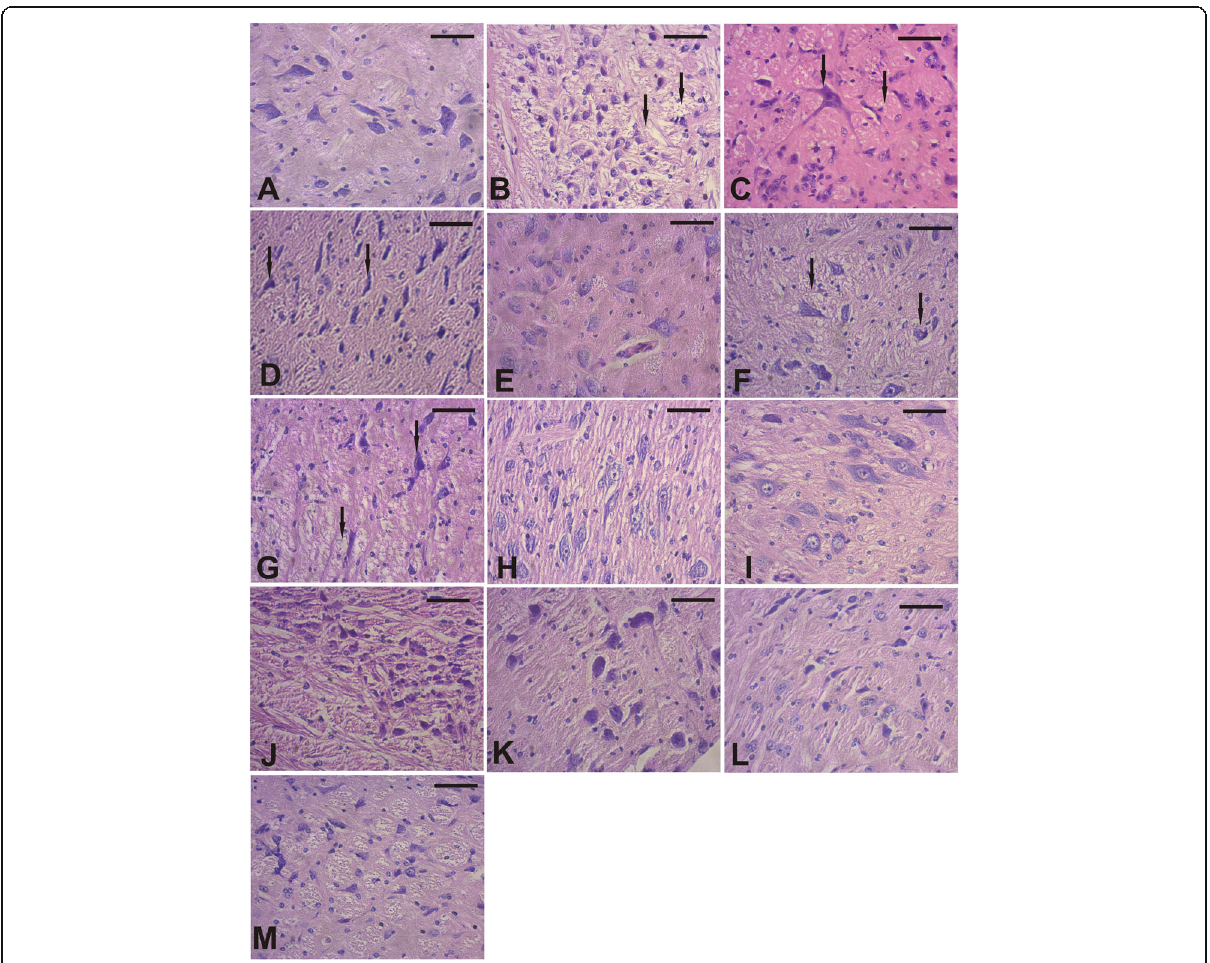
Fig. 8 Photomicrographs of the cerebral cortex showing neurons of the control group ( a ). The acrylamide-administrated groups at 30 days (arrows, b ), 45 days (arrows, c ), and 60 days (arrows, d ) showing gradual shrinkage of neurons. The chips feeding groups at 30 days ( e ), 45 days (arrows, f ), and 60 days (arrows, g ) showing also the gradual neuronal shrinkage and glial vacuolation. The BV- and BPF-treated groups at 60 days ( h , i ) showing similarity to the control. The acrylamide-administrated groups treated with either BV or BPF showing recovery ( j , k ). The chips feeding groups treated with either BV or BPF showing recovery ( l , m ). H&E stain; scale bar 10 μ